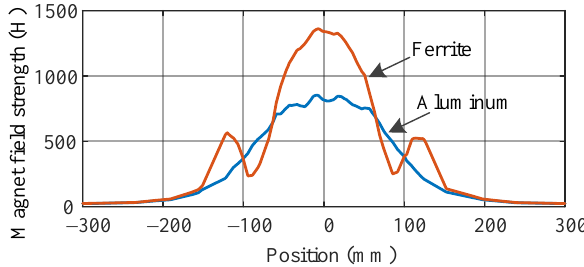
Figure 6. Distribution diagrams of magnetic field strength for different materials. ( a ) Aluminum. ( b ) Ferrite.